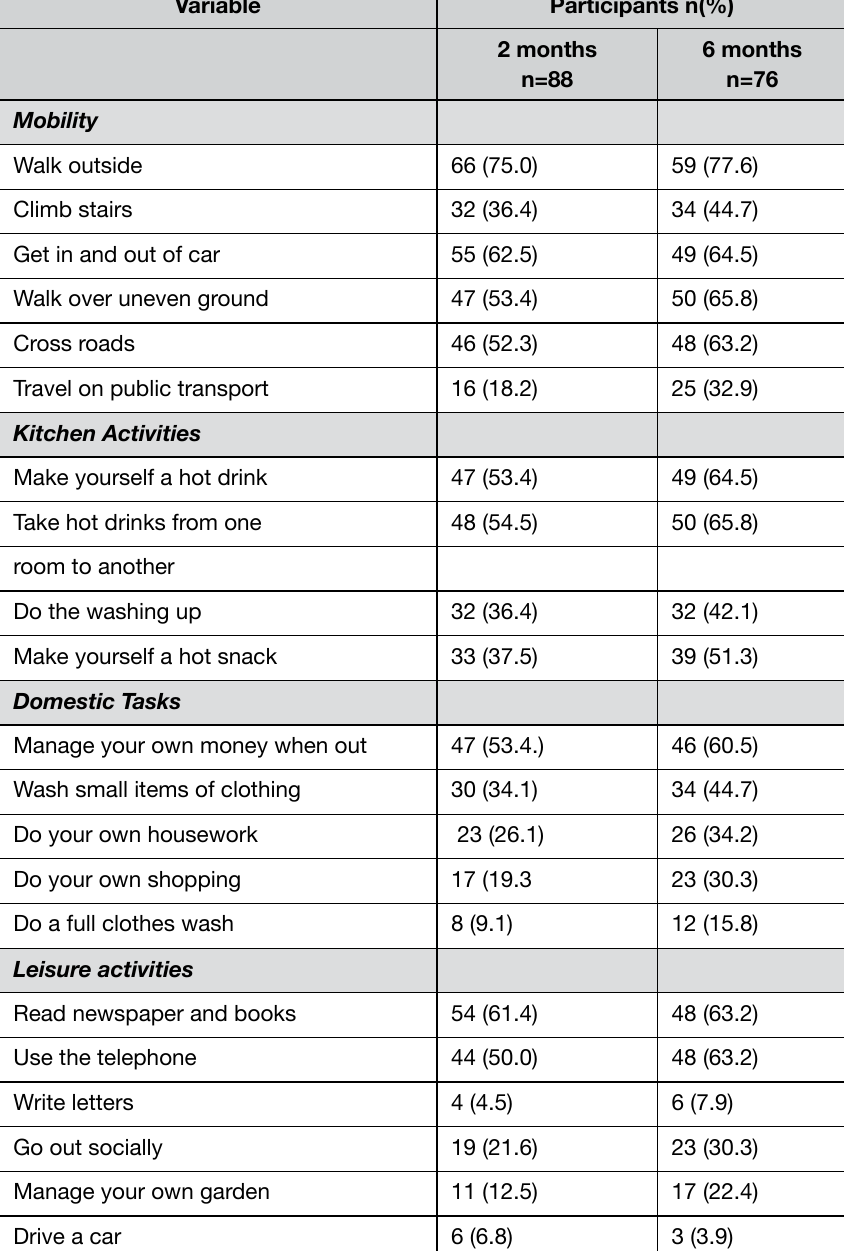
Table: 3. number (%) of participants independent in items of the neADl at two months and six months post stroke onset.